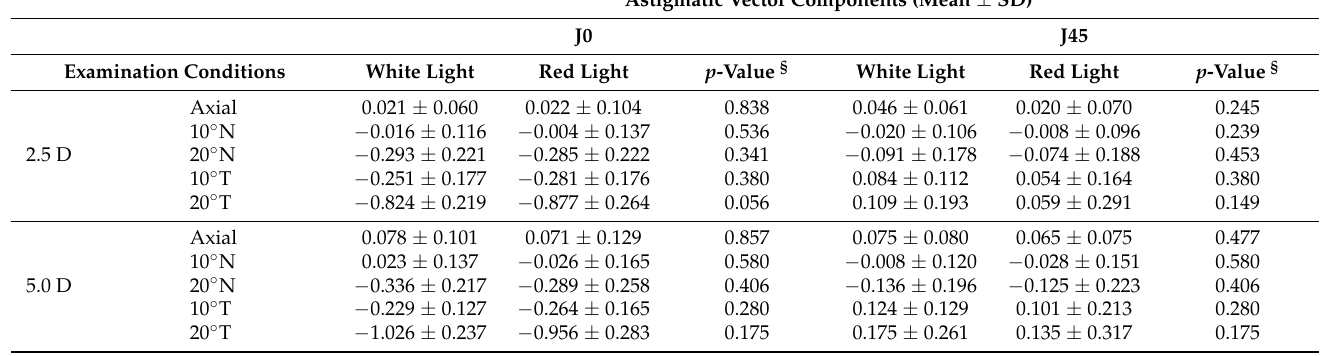
Table 3. Astigmatic vector components (mean ± standard deviation) for both illumination conditions (red and white light) at each eccentricity and accommodative demand. (N: nasal retina; T: temporal retina).